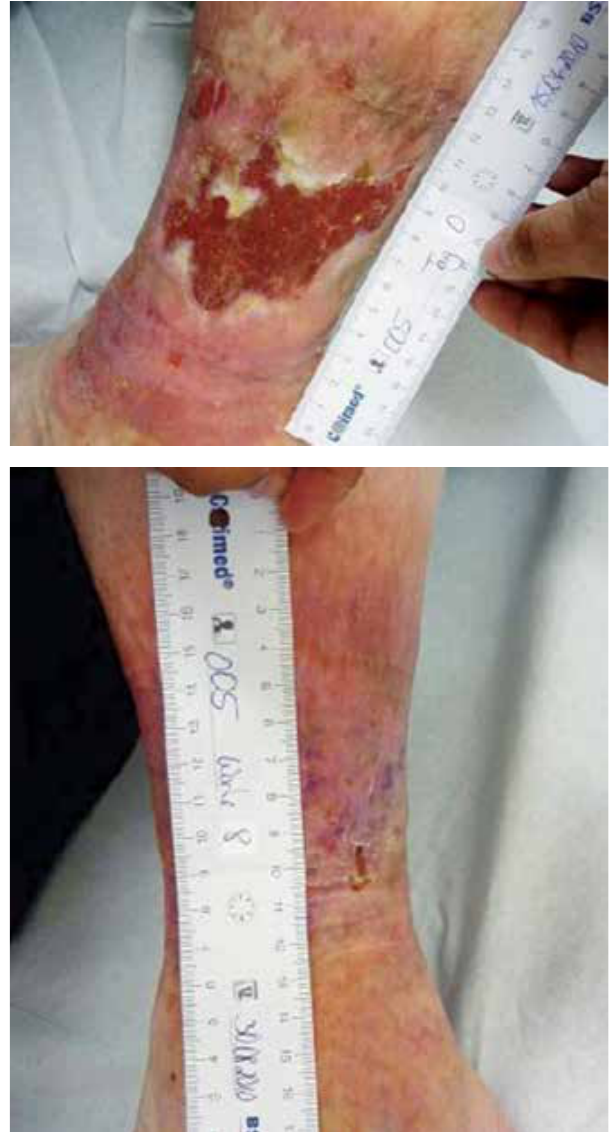
Figure 1: Venous leg ulcer; a) at baseline (15 June 2010), b) final outcome of treatment (30 Aug.